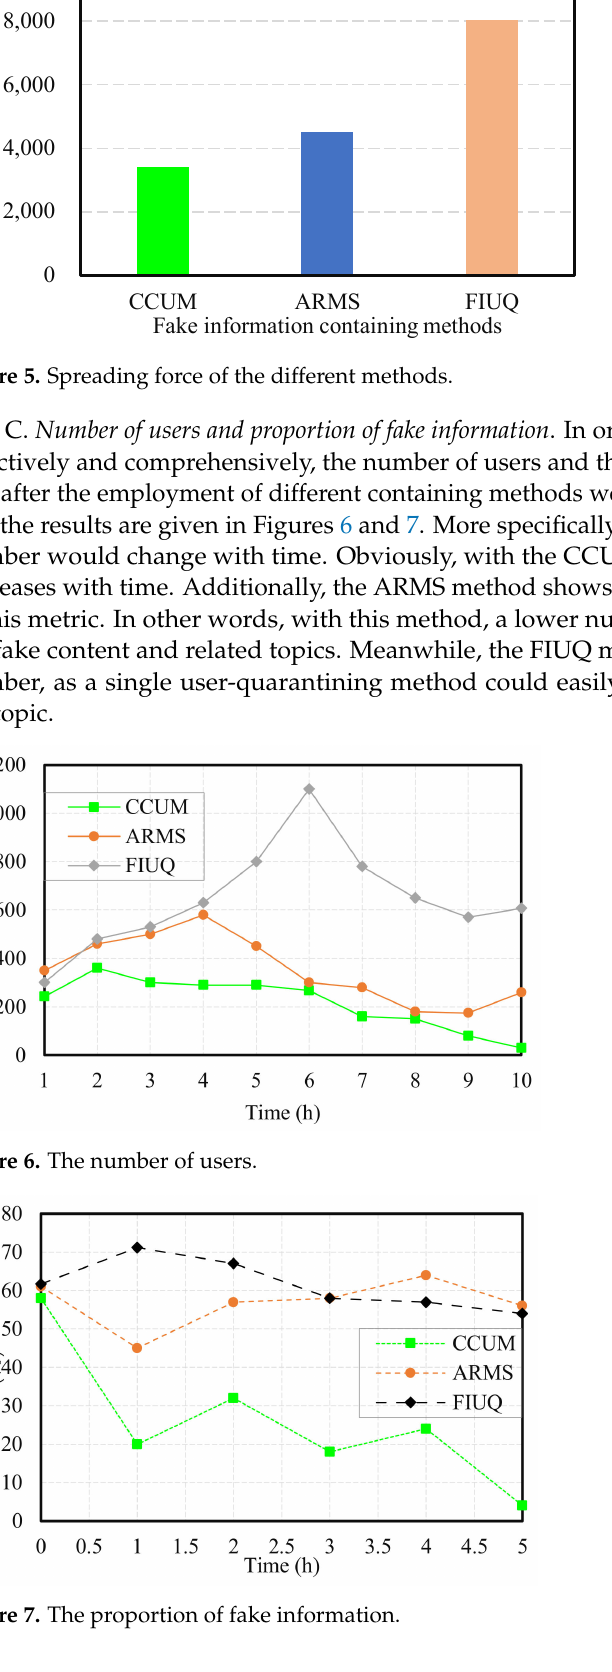
Figure 4. Fake information detection accuracy.